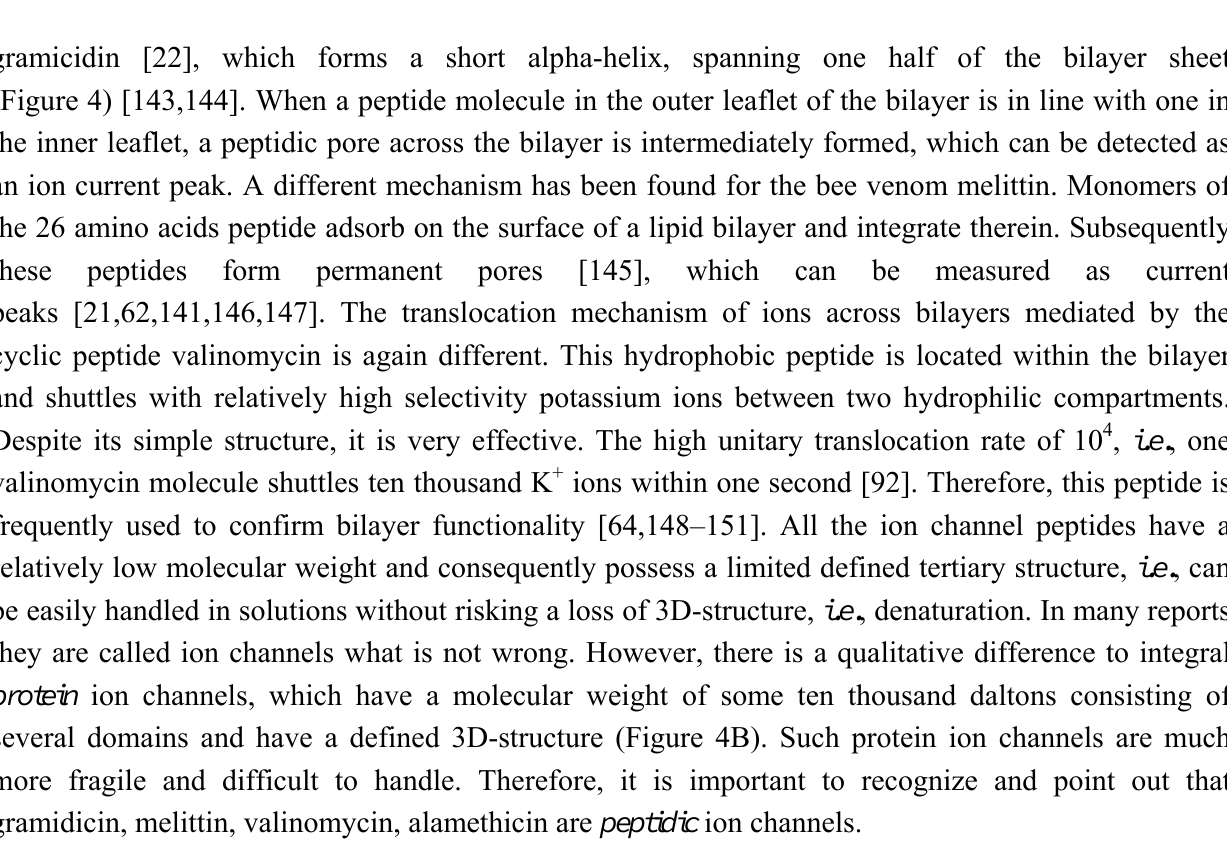
Figure 4. Peptidic and protein ion